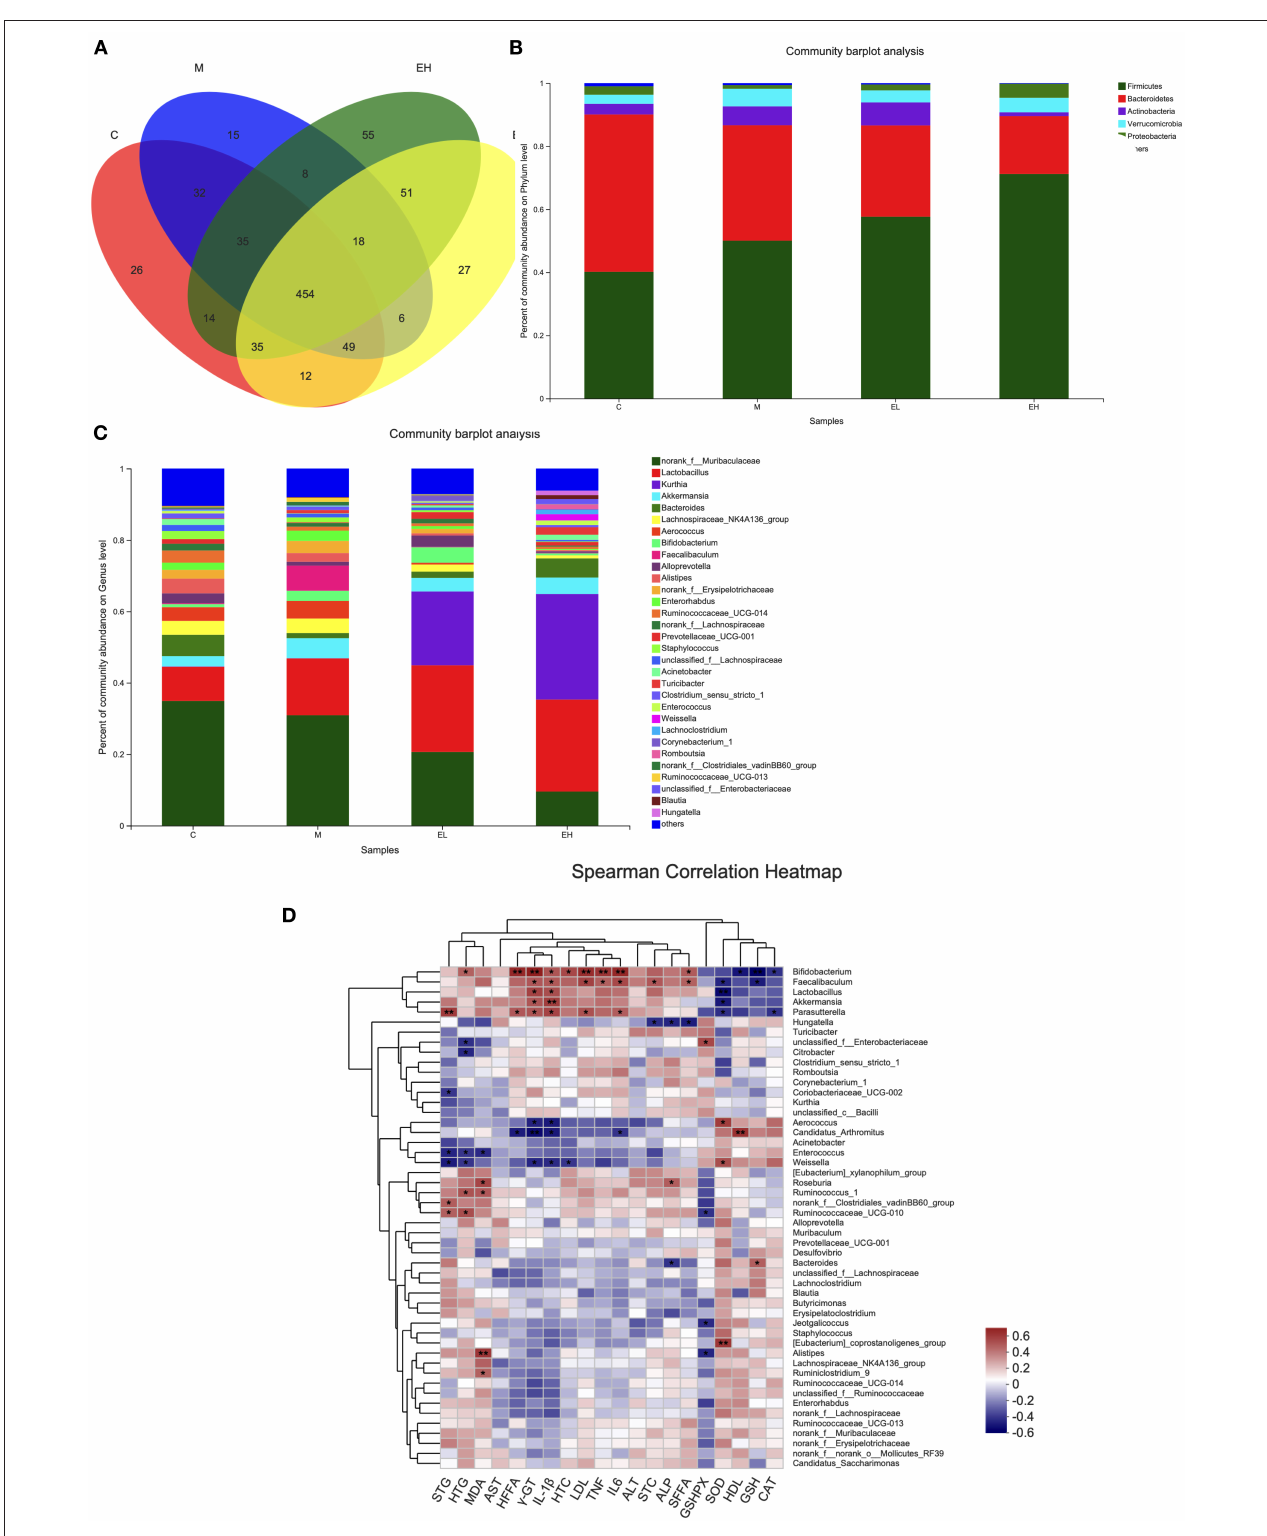
FIGURE 8 | Effect of ellagic acid on the intestinal microbial composition in ALD mice. (A) Venn plot; (B) Bacterial profile at phylum level; (C) Bacterial profile at genus level; (D) Heatmap of Spearman correlation analysis of physical parameters and microbiota based on species level. Values represent the mean ± SD ( n ≥ 5). C, normal group; M, model group; EL, low dose of ellagic acid group; EH, high dose of ellagic acid group.